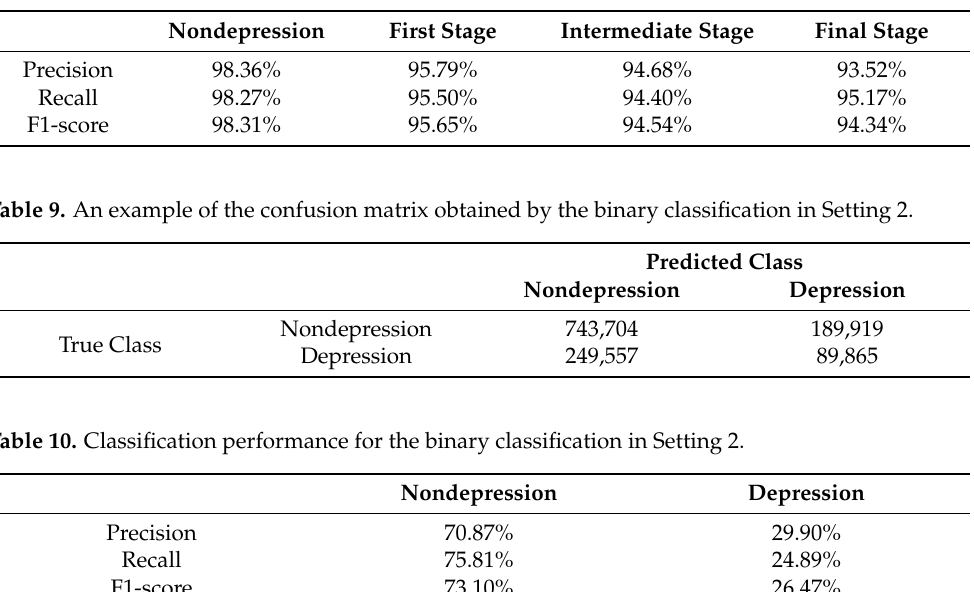
Table 8. Classification performance for the four-class classification in Setting 1.